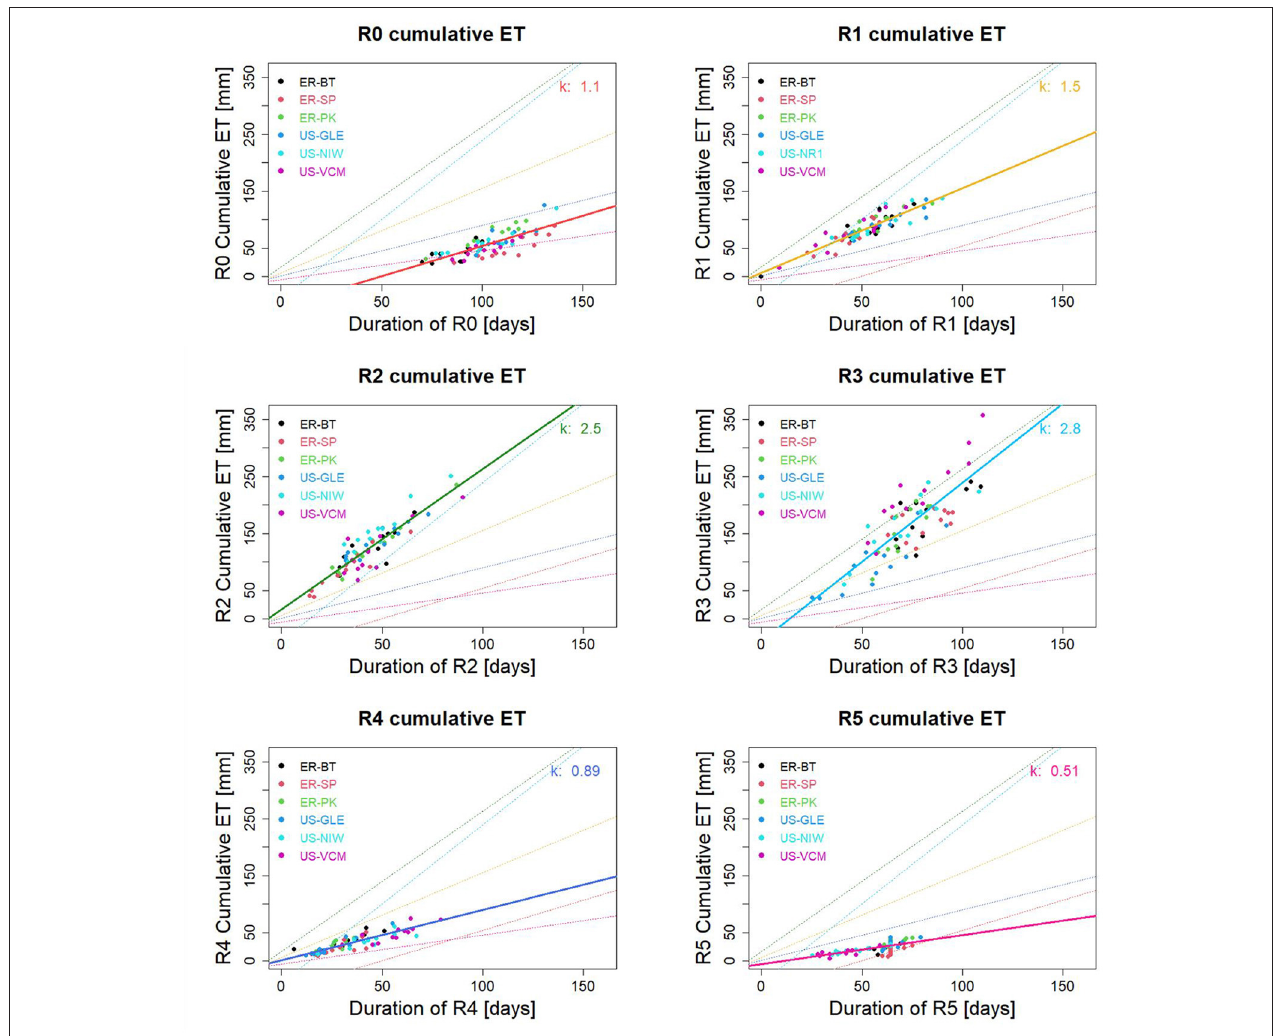
FIGURE 7 | Correlation between subseasonal regime duration and regime cumulative ET. Colored points represent different sites. Colored lines are regression lines for each subseasonal regime between regime cumulative ET and subseasonal regime duration. k -values measure regime-mean ET [mm/day].